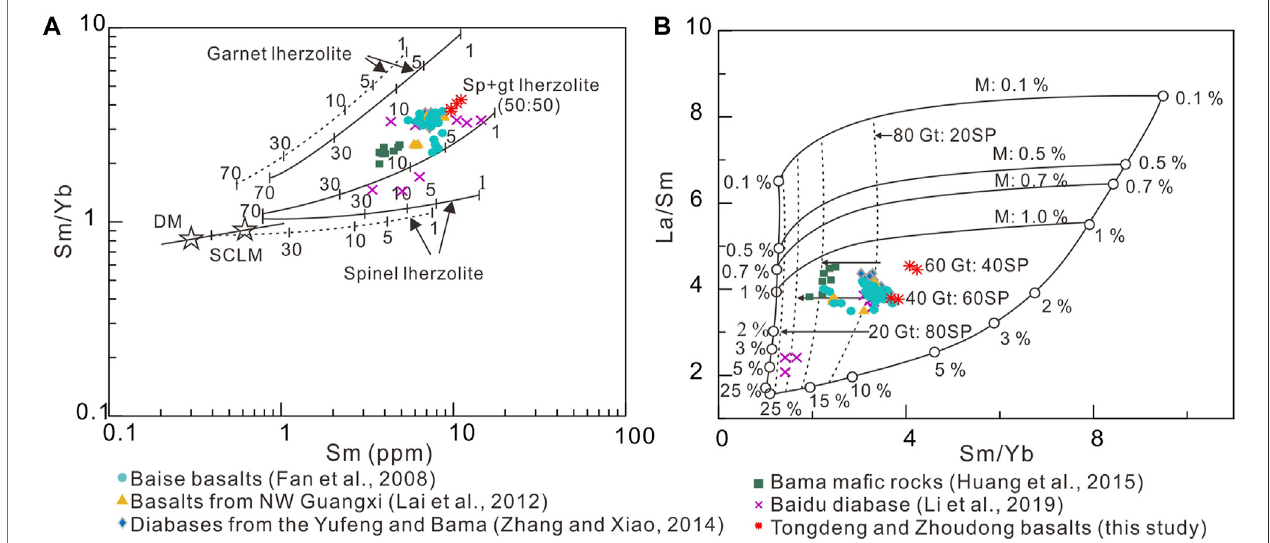
FIGURE 10 | (A) Sm/Yb-Sm diagram (dashed and solid lines are the melting trends for depleted mantle and enriched subcontinental lithospheric mantle, respectively. The numbers beside the lines are degrees of partial melting for a given mantle source); (B) La/Sm-Sm/Yb discrimination diagram for the Longlin basalt samples (After Özdemir and Güleç, 2014; M:0.7, M:1, M:2, M:3, and M:5% represents mixing lines between 0.7, 1, 2, 3 and 5% melts of garnet and spinel peridotite. Dashed lines indicate the relative proportions of melts derived from garnet and spinel peridotite mantle sources contributing to the parental magmas). Data from other basalt units in western Guangxi are shown for